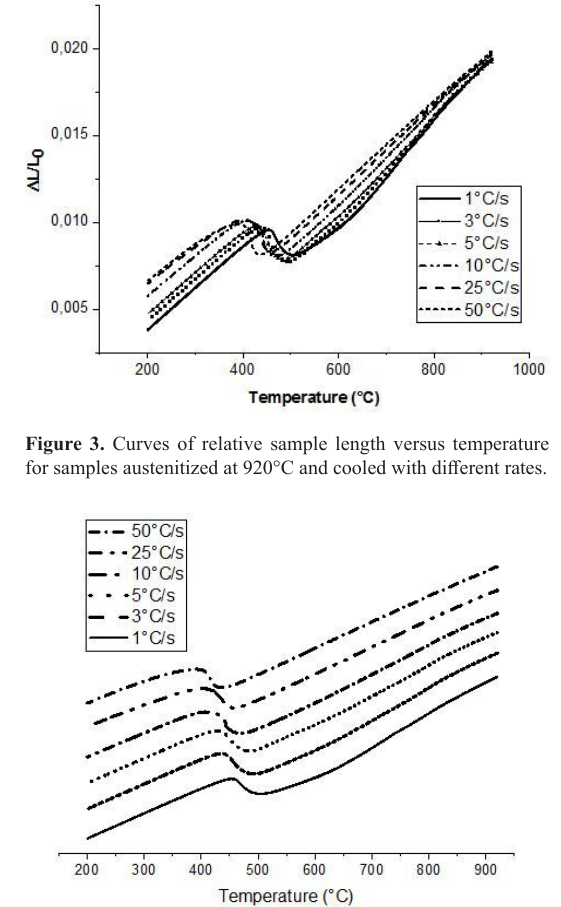
Figure 4. Separately presented curves of relative sample length as a function of temperature for samples austenitized at 920°C and cooled with different cooling